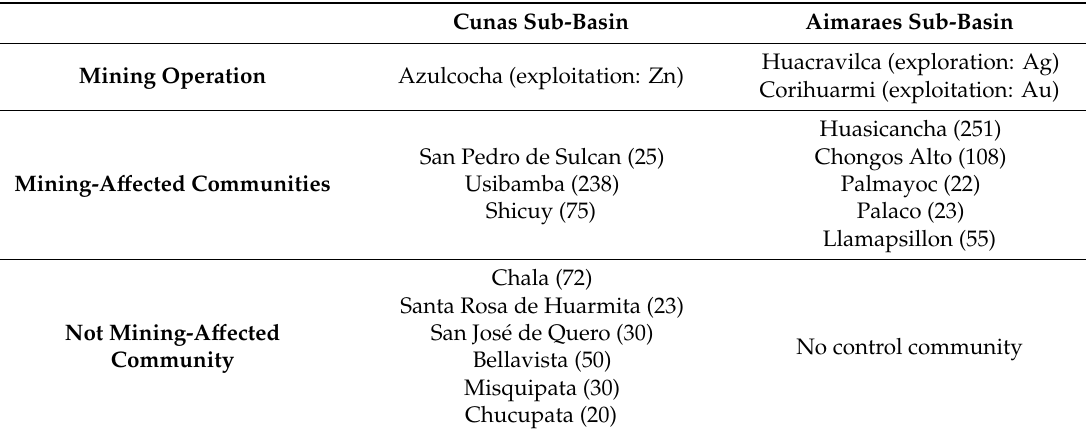
Table 1. Mining operations with stage of use and assessed campesino communities with the number of active members in